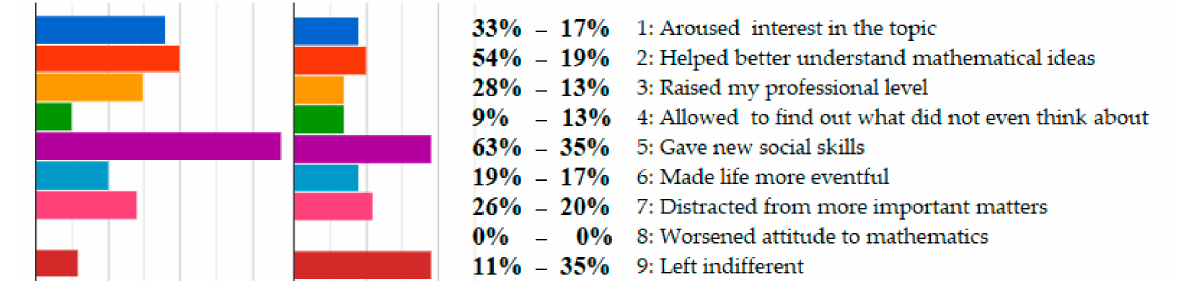
Figure 6. Student assessment of factors affected by the “learning through teaching” approach. On the left—assessment of factors in the role of an instructor; on the right—assessment of factors in the role of a student (students could choose any number of significant factors of